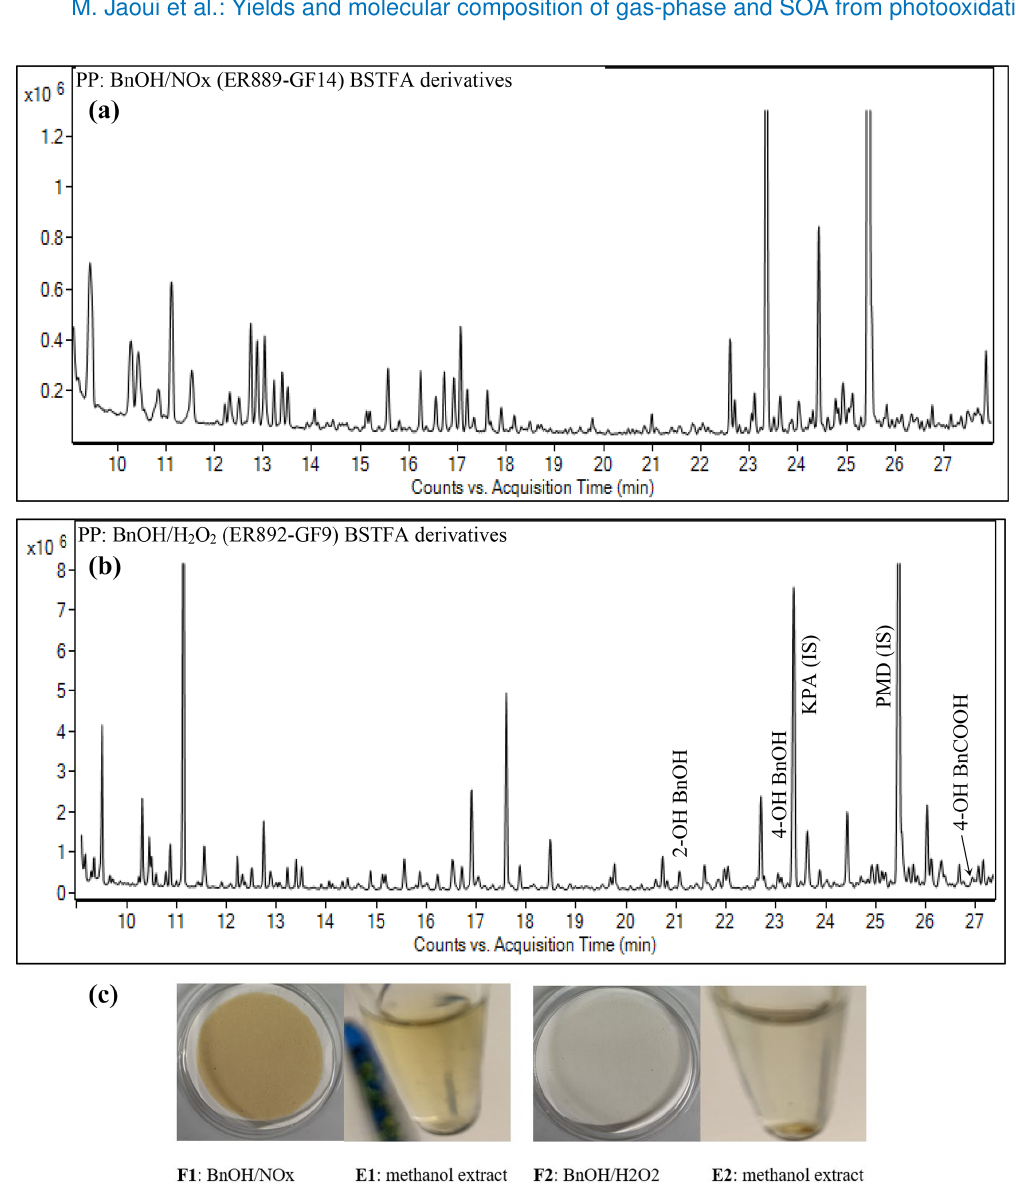
Figure 2. Portion of GC-MS total ion chromatograms (EI mode) of particle-phase extracts: (a) BSTFA derivatized sample from ER889 (presence of NO x ), (b) BSTFA derivatives from ER892 (absence of NO x ), and (c) the effect of mixture changes in filter and methanol extract appearance – BnOH / NO x filter (F1) and BnOH / H 2 O 2 (F2). The same volume of air was sampled on each